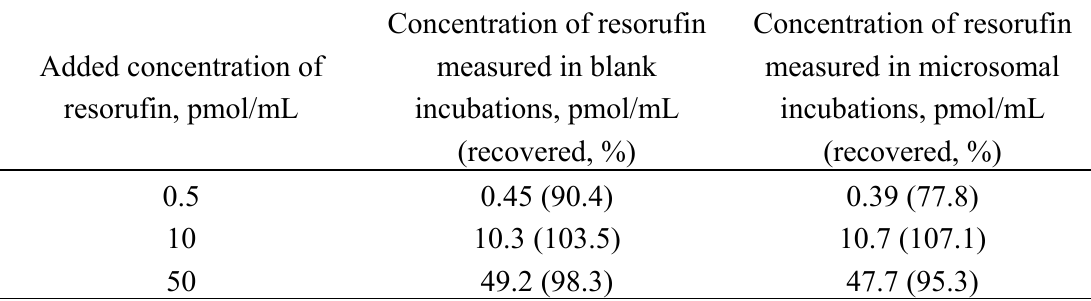
Table 1. Assessment of recovery and matrix effect on resorufin